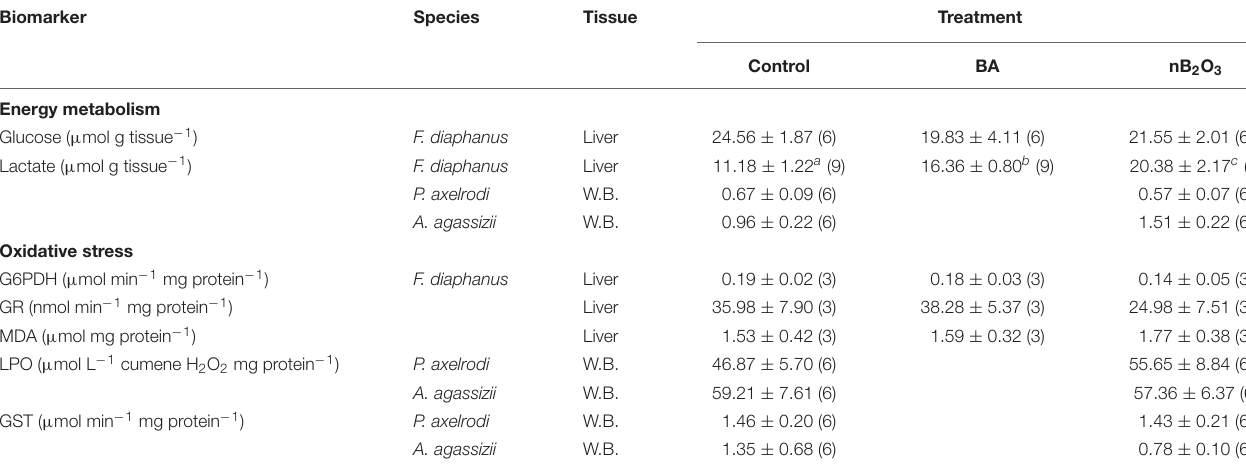
TABLE 1 | Effects of BA (10 mg L − 1 ) and nB 2 O 3 (1.0 mg L − 1 for Fundulus diaphanus , 10.0 mg L − 1 for Paracheirodon axelrodi , and Apistogramma agassizii ) exposure on biomarkers of energy metabolism and oxidative